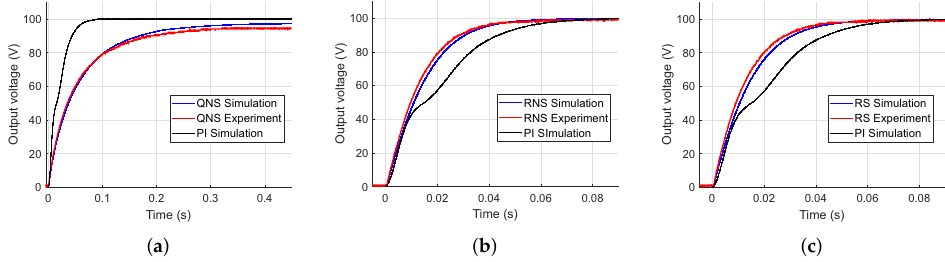
Figure 6. Step response of the min-type controllers ( a ) Quadratic Non-Sampled (QNS) Controller, ( b ) Robust Non-Sampled (RNS) Controller, ( c ) Robust Sampled